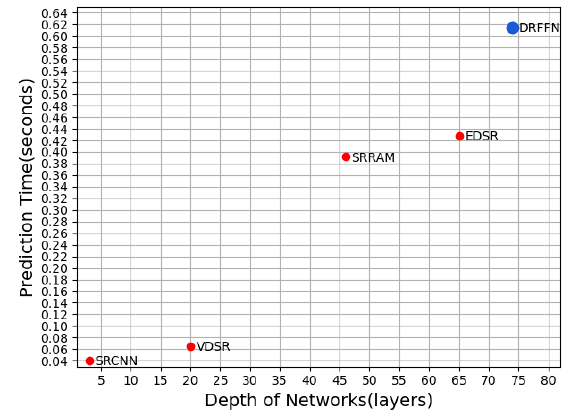
Figure 9. Time vs. Depth on Set5 (×4).